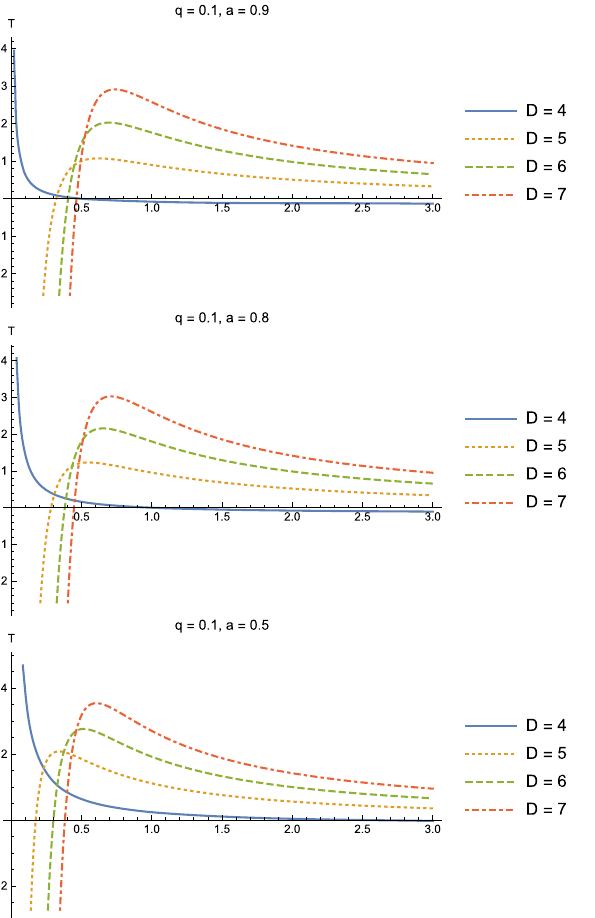
Fig. 7 The Hawking temperature in D-dimensional TGR as function of r h for different values of a